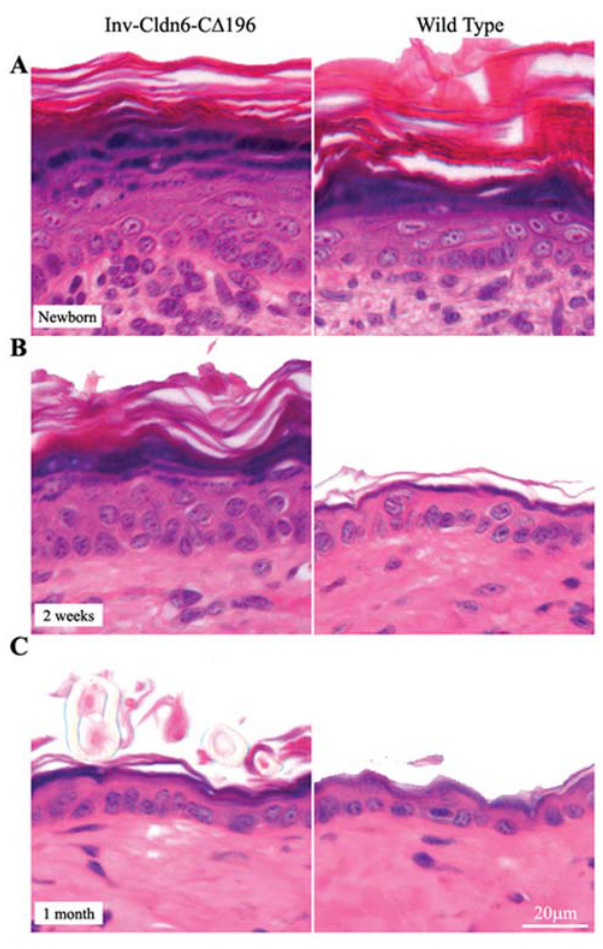
Figure 2. Histological abnormalities in the Inv-Cldn6-C D 196 transgenic epidermis. Histological analysis of newborn ( A ) Inv- Cldn6-C D 196 transgenic mice as compared to the wild type revealed a moderately thicker epidermis in transgenic samples, with a thicker stratum corneum, a less-compacted granular layer and an overall expanded suprabasal compartment. At 2-weeks of age ( B ), the Inv- Cldn6-C D 196 epidermis remained somewhat less mature and thicker than that of the wild type; however by 1-month of age ( C ) the transgenic and wild type samples were histologically indistinguishable.